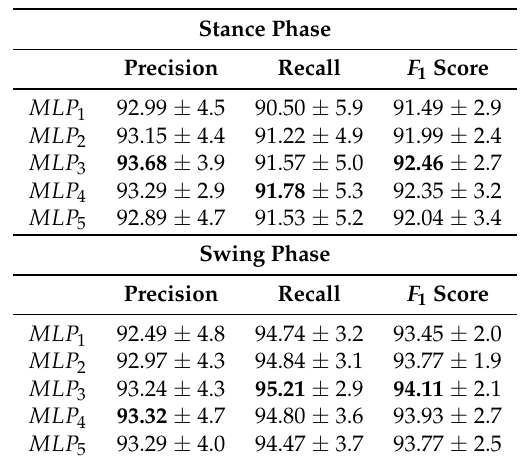
Table 3. Gait phase classification performances for stance and swing phases in unlearned subjects (set US). Precision, recall and F 1 scores are averaged over the 23 folds.